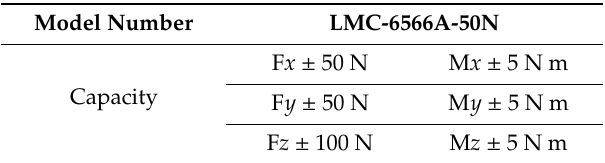
Table 2. Model number and capacity of the load cell [40].